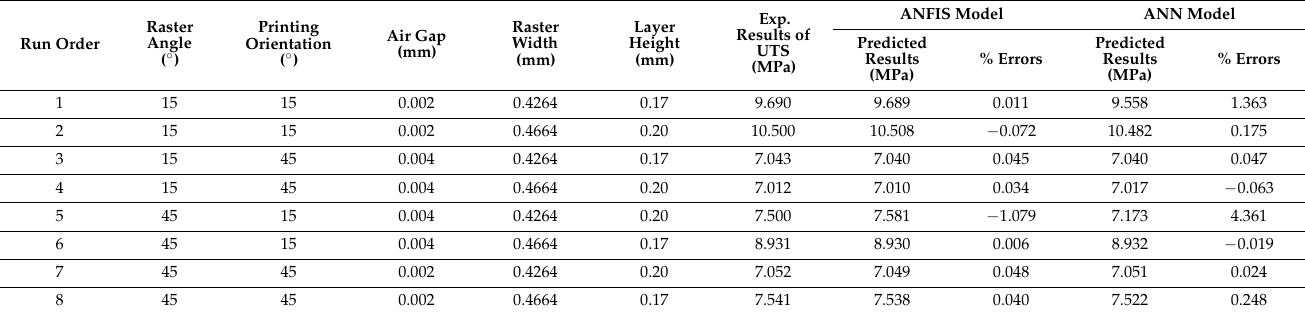
Table 9. Process parameters for